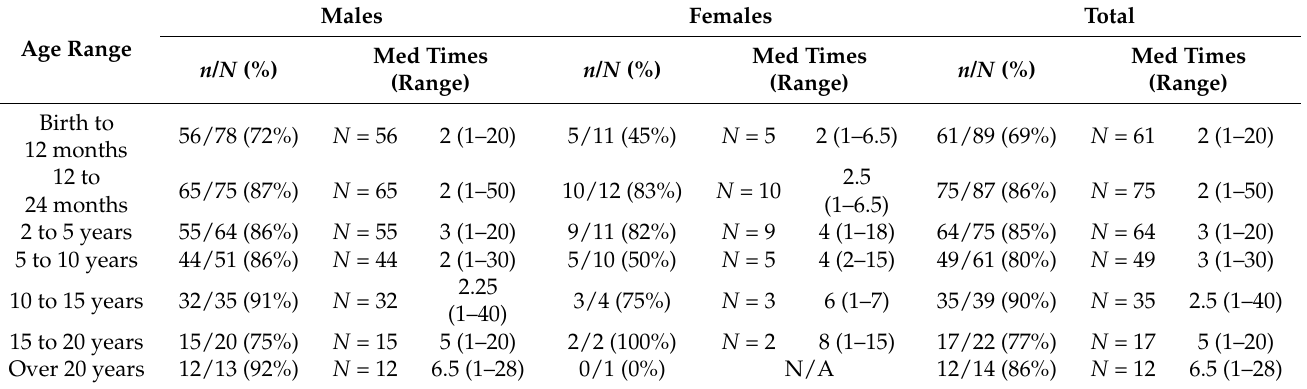
Table 3. Proportion of individuals who have been hospitalised for a respiratory problem per age epoch and the median number of estimated hospitalisations.